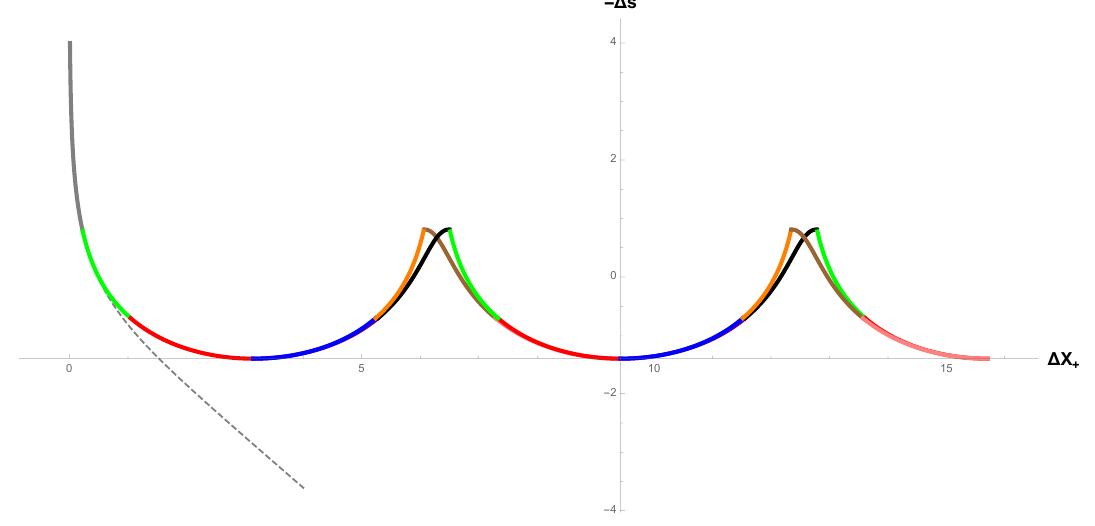
Figure 8 . All branches of geodesic length as function of (cid:1) X + for M = 1 and u (cid:3) = 5. As we increase the radius the branches approach the pure AdS 3